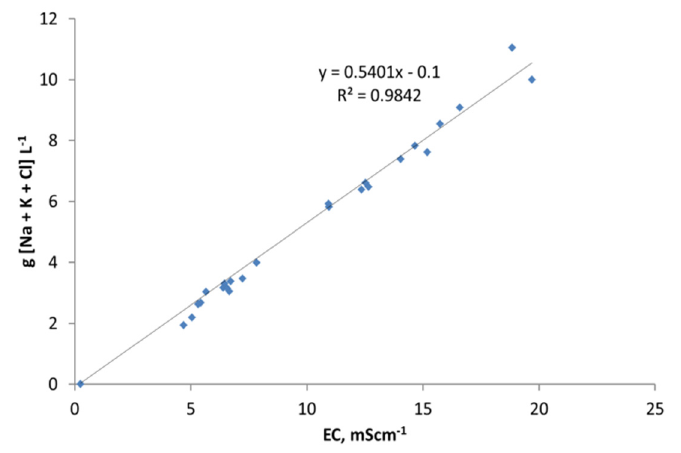
Figure E3. Control Relationship between measured EC and measured direct ion concentrations of Na + K + Cl. n = 27. Temperature = 4–6